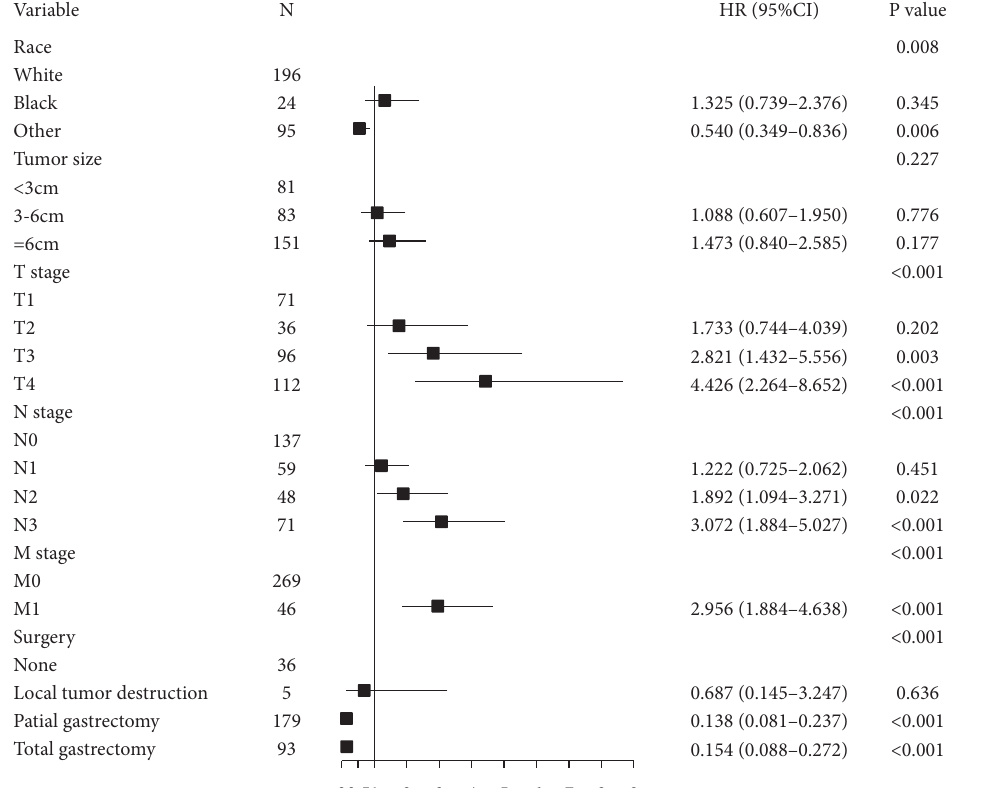
Figure 4: Forest plot showing results of the multivariate Cox regression model for the cancer-specific survival of gastric cancer patients with adenocarcinoma with mixed subtypes